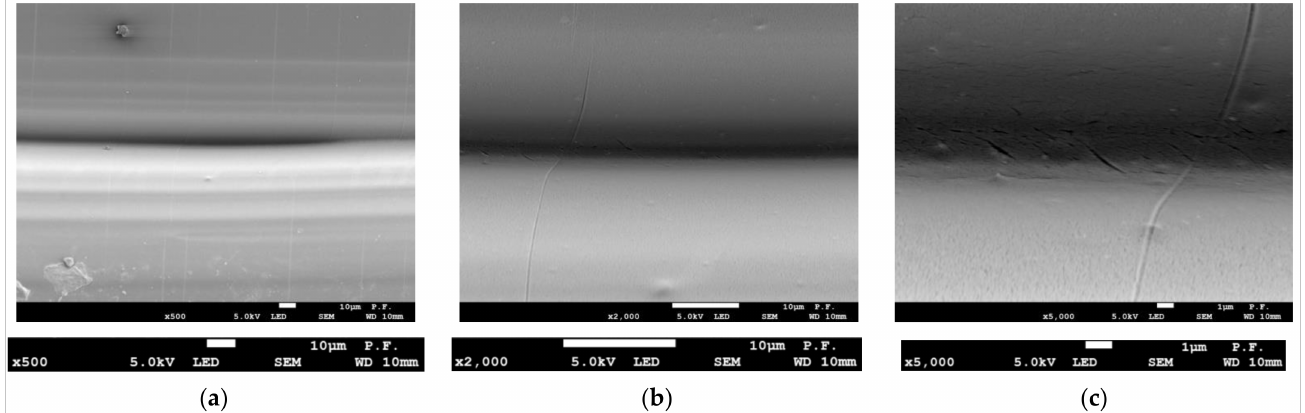
Figure 15. Side views of layers 1.8 mm thick PLA specimen after failure, ( a ) × 500 magnification ( b ) two filaments in